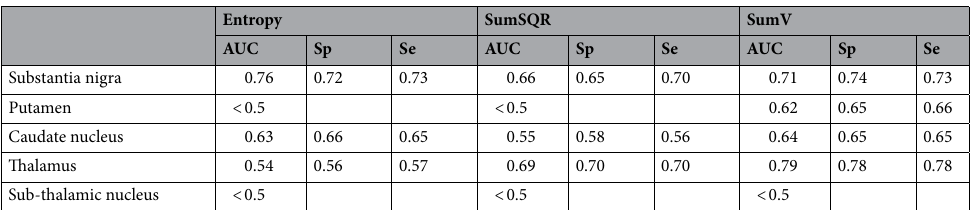
Table 2. Receiver operating characteristic (ROC) analysis of the three texture features entropy, sum square (SumSQR) and sum variance (SumV) for discrimination of the two PD patient groups. AUC area under the curve, Sp specificity, Se